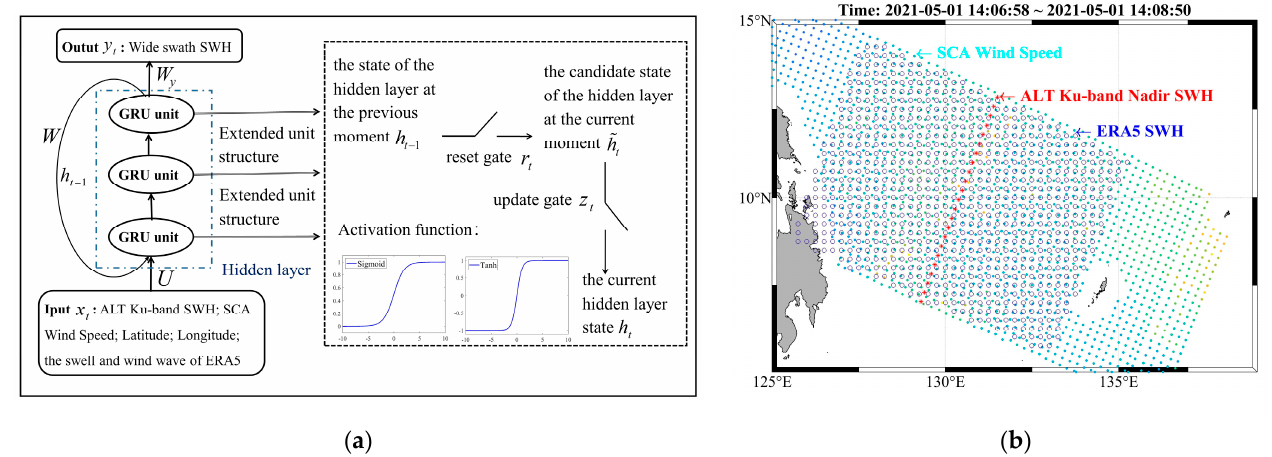
Figure 3. ( a ) The structure diagram of the GRU network to obtain the wide swath SWH; ( b ) A schematic diagram of the data parameters and widths acquired by the ALT, SCA, and ERA5. It is worth noting that the widths displayed by ERA5 are selected according to comprehensive consideration of model efficiency and effectiveness.